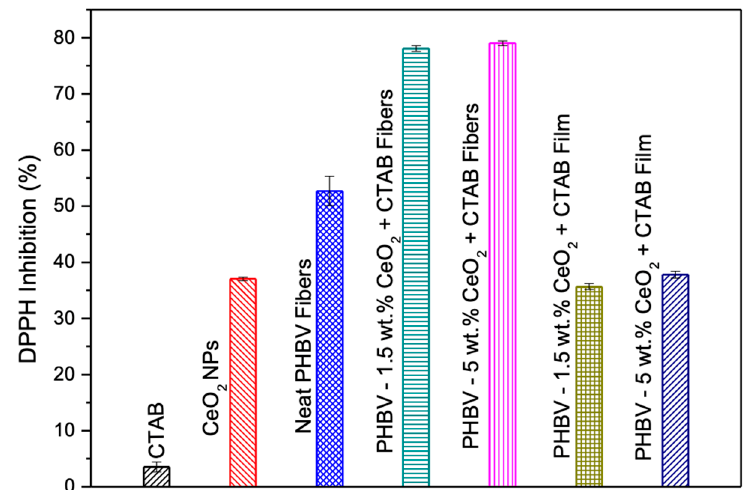
Figure 14. Comparison of the 2,2-diphenyl-1-picrylhydrazyl radical (DPPH) inhibition percentage (%) for hexadecyltrimethylammonium bromide (CTAB), cerium oxide nanoparticles (CeO 2 NPs), and electrospun poly(3-hydroxybutyrate-co-3-hydroxyvalerate) (PHBV) fibers and films containing 1.5 and 5.0 wt.% CeO 2 NPs.